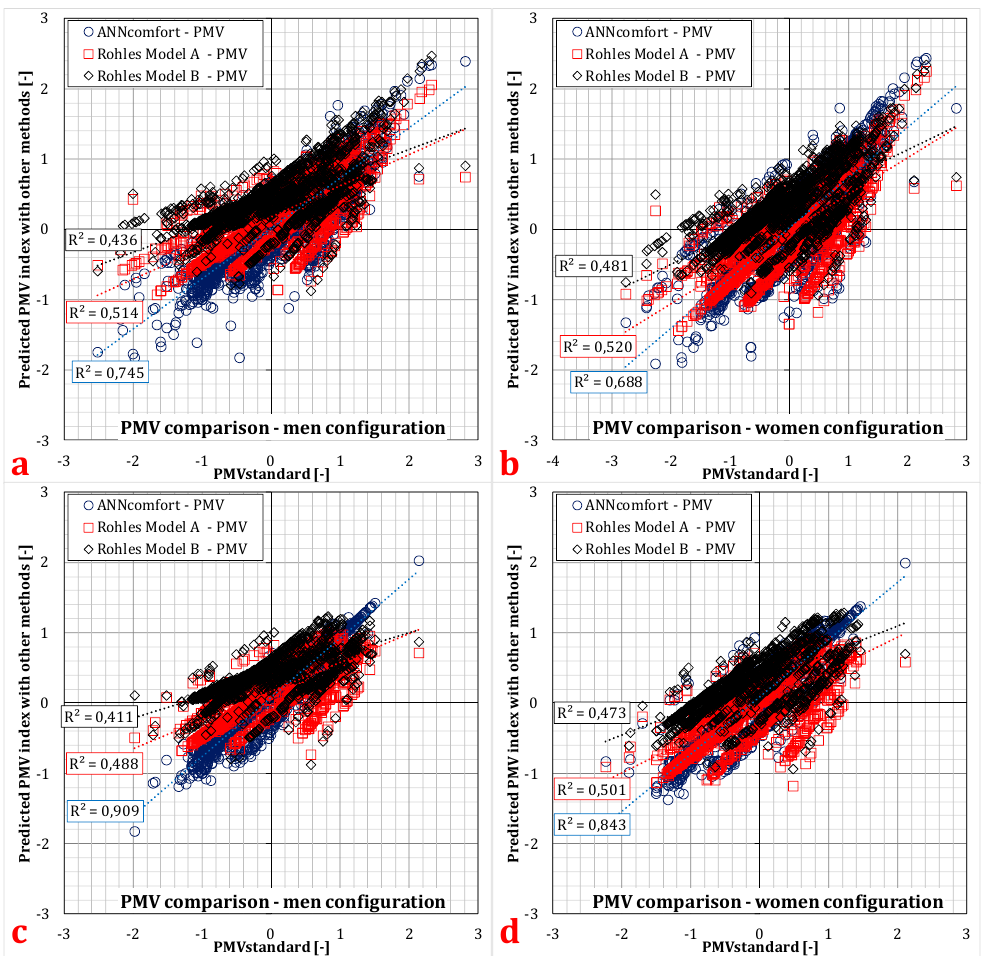
Figure 8. PMV index comparison for men and women configurations: ( a ) and ( b ) related to range δ SD1 , ( c ) and ( d ) related to range δ SD2 .